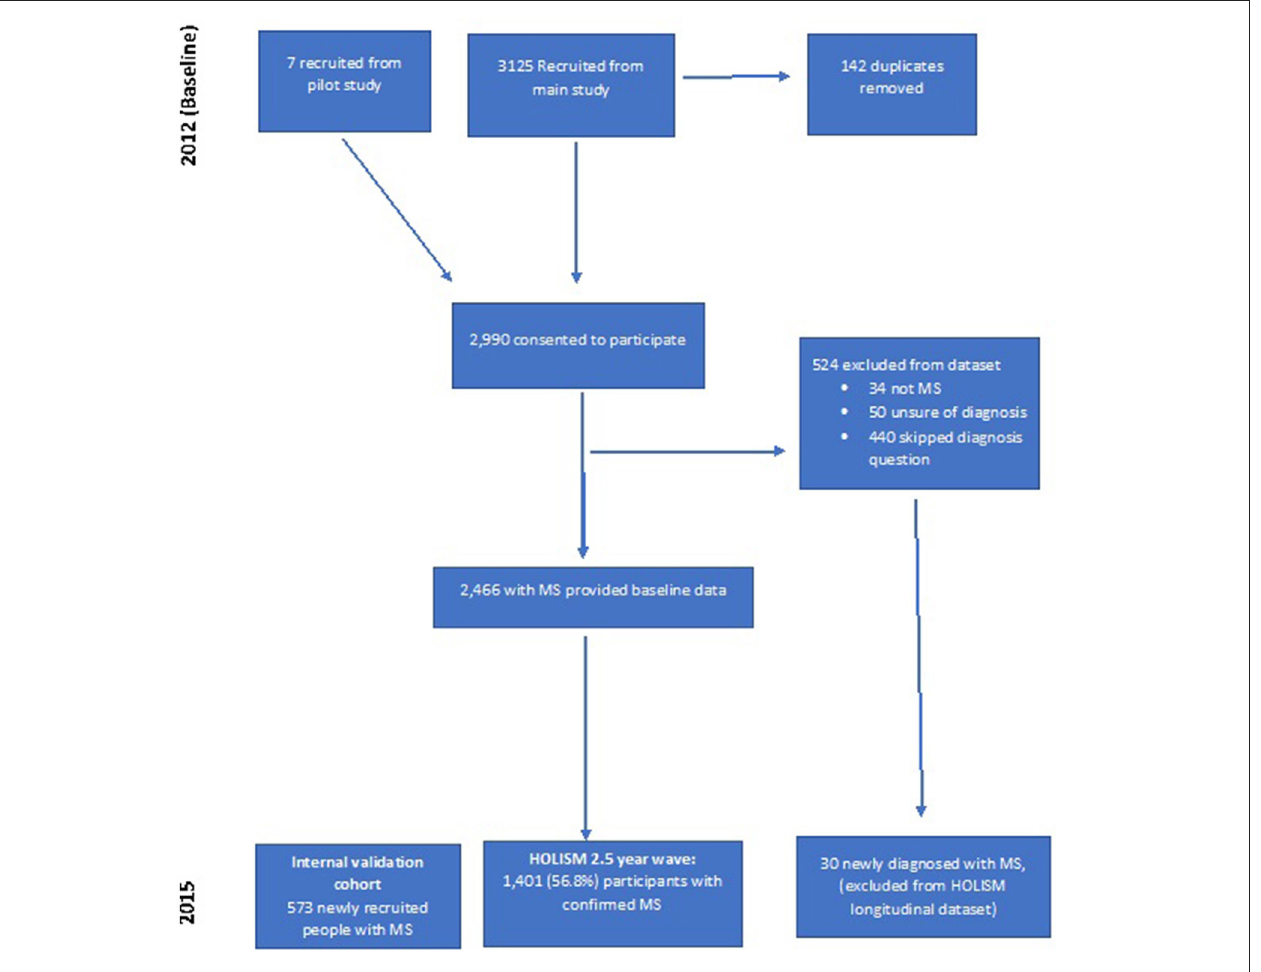
FIGURE 1 | Flowchart of